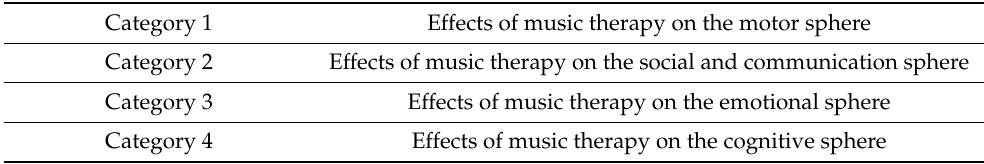
Table 2. Categories established for the analysis of the selected